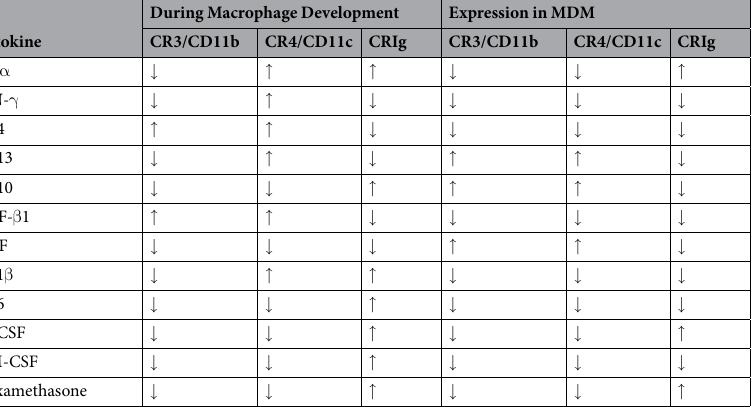
Table 1. Effect of cytokines on CR3/CD11b, CR4/CD11c and CRIg mRNA expression in macrophages. The ↑ and ↓ arrows represents an increase and a decrease in receptor